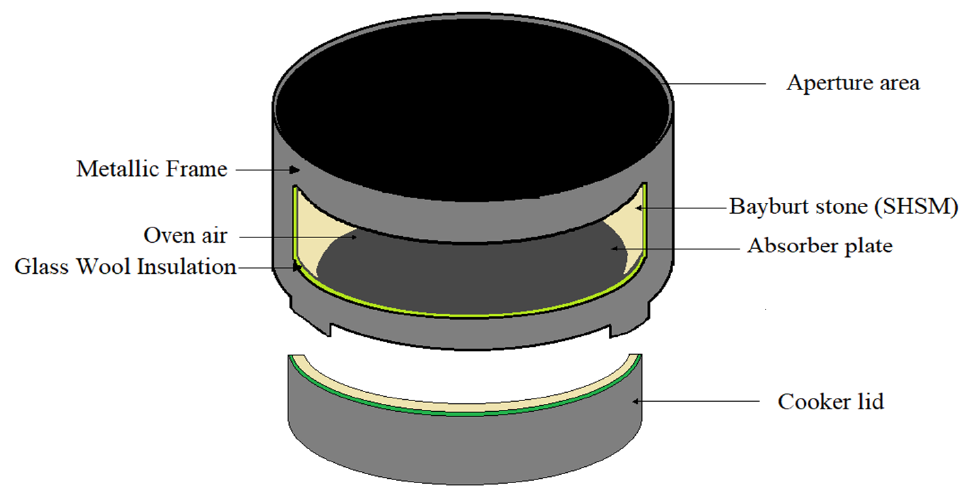
Figure 5. Cylindrical SBC with sensible heat storage material (SHSM). Reprinted/adapted with permission from (2018) Cuce et al. [92].